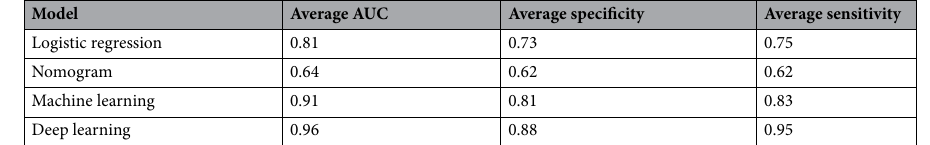
Table 2. Model results comparison. The average area under the curve, sensitivity, and specificity for each model. AUC—area under the curve.